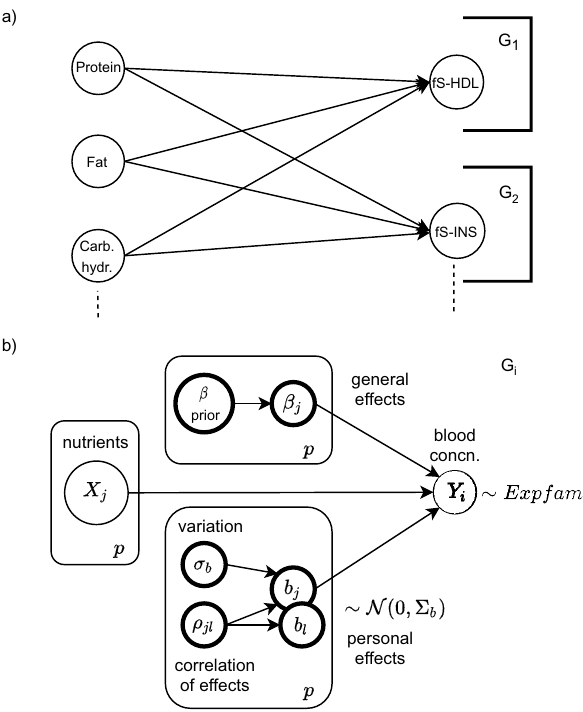
Figure 2. In ( a ) a bipartite Bayesian network is constructed from a few of the variables in Sysdimet data. The overall network factorizes into subnetworks G 1 and G 2 that form independently estimated local probability distributions. In ( b ) a general concentration-specific graphical model G i is shown. It includes p observed random variables X for the nutrient levels and the corresponding concentration level Y i . The latent variables of each nutritional effect are estimated from the data. Personal variations b i are assumed to follow Normal distribution, but blood concentrations can also be better modeled with Gamma distribution. Evaluation of the directed graphical model starts from the prior and the observed nodes. Their sampled values are propagated as input to downward nodes, and finally, the linear predictor (3) in the concentration node Y i gathers them all and results in an